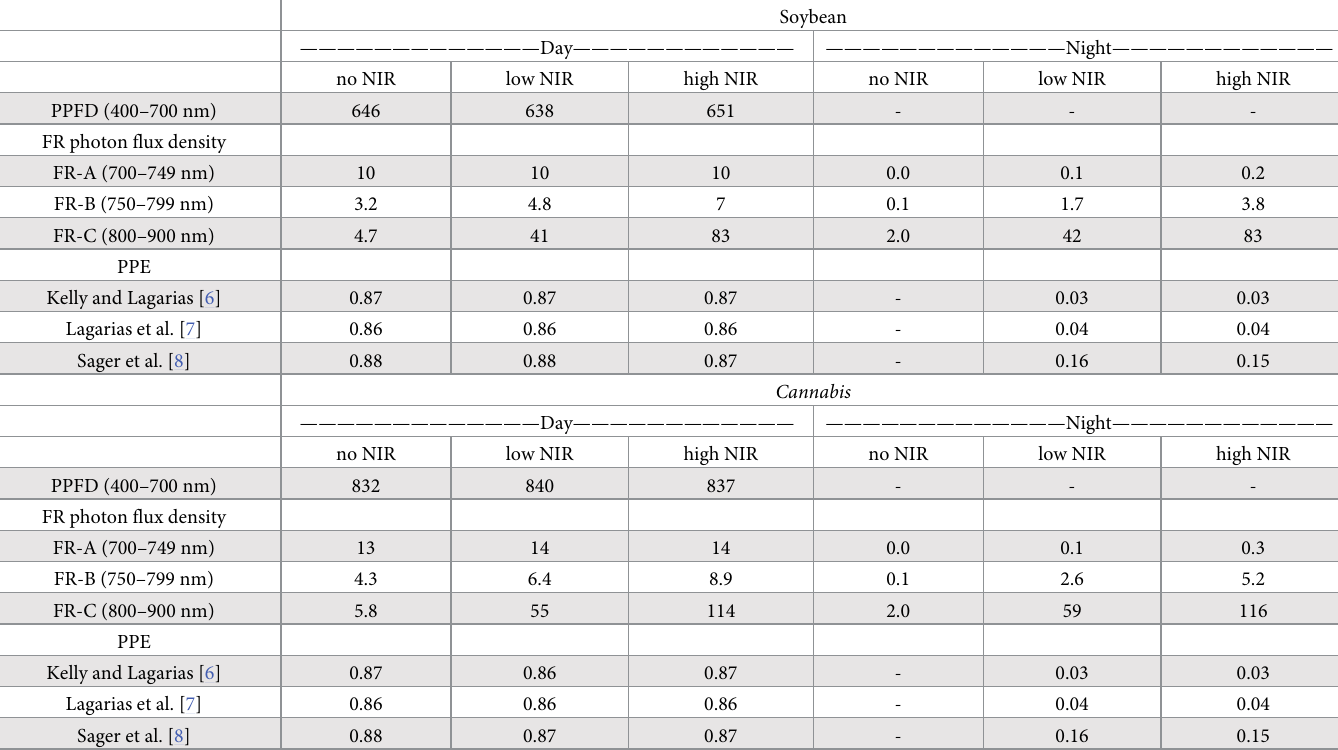
Table 2. Spectral analysis of NIR treatments.